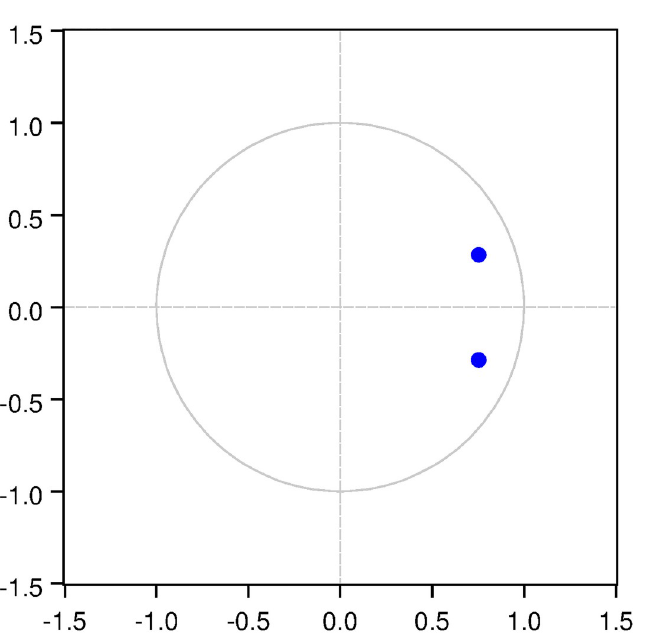
Fig 14. Inverse roots of AR characteristic polynomial for British data when P = 1 (Fisherian model).